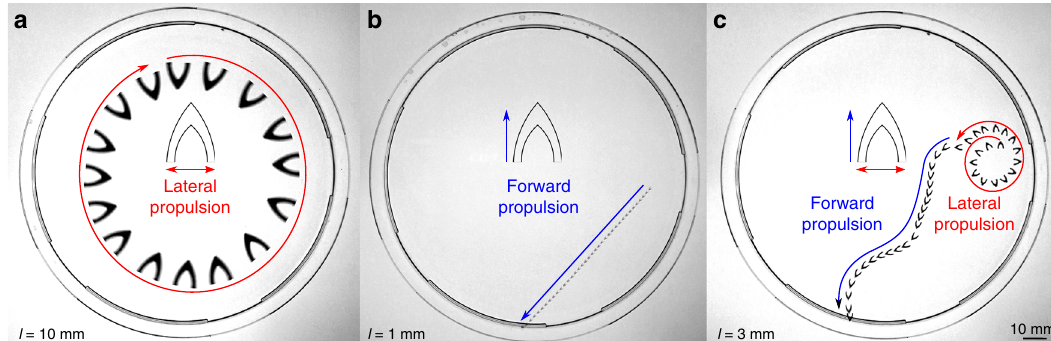
Fig. 2 Protein motor propulsion modes. Motors with characteristic length scales l = 10 mm exhibit lateral propulsion, l = 1 mm – 100 μ m forward propulsion, and l = 3 – 5 mm alternating propulsion between the two